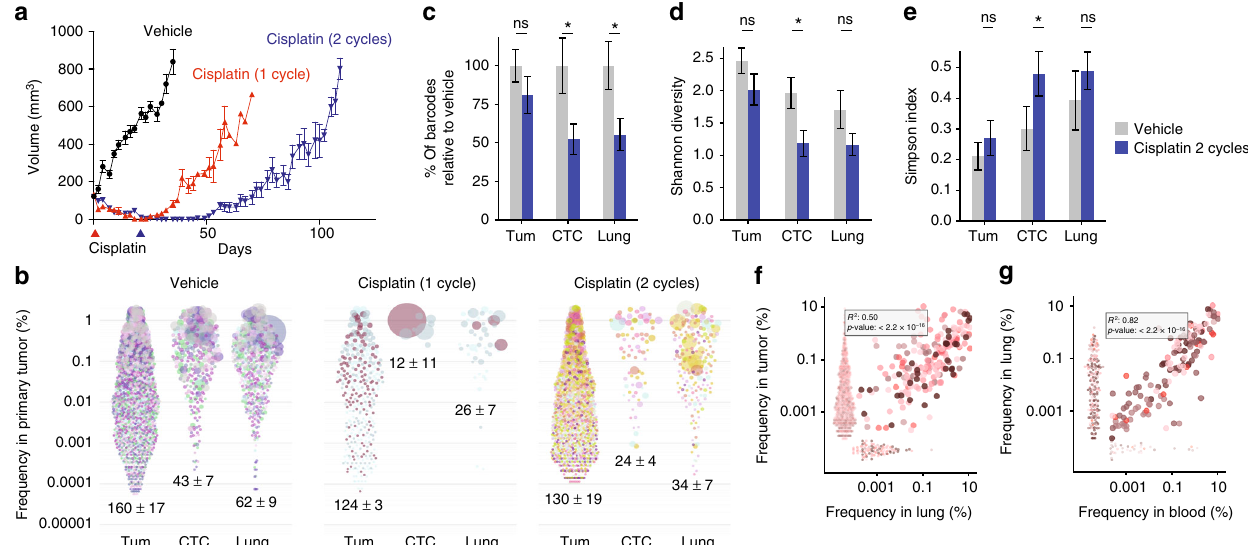
Fig. 6 The effect of cisplatin on clonal diversity. a Average volume of tumors from PDX-110 treated with vehicle, or cisplatin (6 mg/kg, treatment time indicated by a triangle at the bottom for either 1 or 2 cycles). Tumor volume from 12 mice per group (mean ± SEM). b Bubble plot of clonal relationships between indicated tissues of all mice, with indicated average barcode number per mouse (mean ± SEM) in tumor, CTC, and lung. Colors indicate different mice. c Percentage of barcoded clones in vehicle or cisplatin treatment group at tumor relapse relative to vehicle-treated controls in indicated tissues (shown is mean ± SEM, ns: t -test, not signi fi cant, * p < 0.05). d Shannon diversity and e Simpson index of barcode distribution in different organs in the treated and untreated group. Scatter plots showing the correlation between the frequencies of barcoded clones in primary tumor versus f lung ( n = 10 mice) and g blood and lung ( n = 9 mice). Inset indicates adjusted R 2 and p -values using the F -test for linear regression on log-transformed frequencies of barcodes detected in both